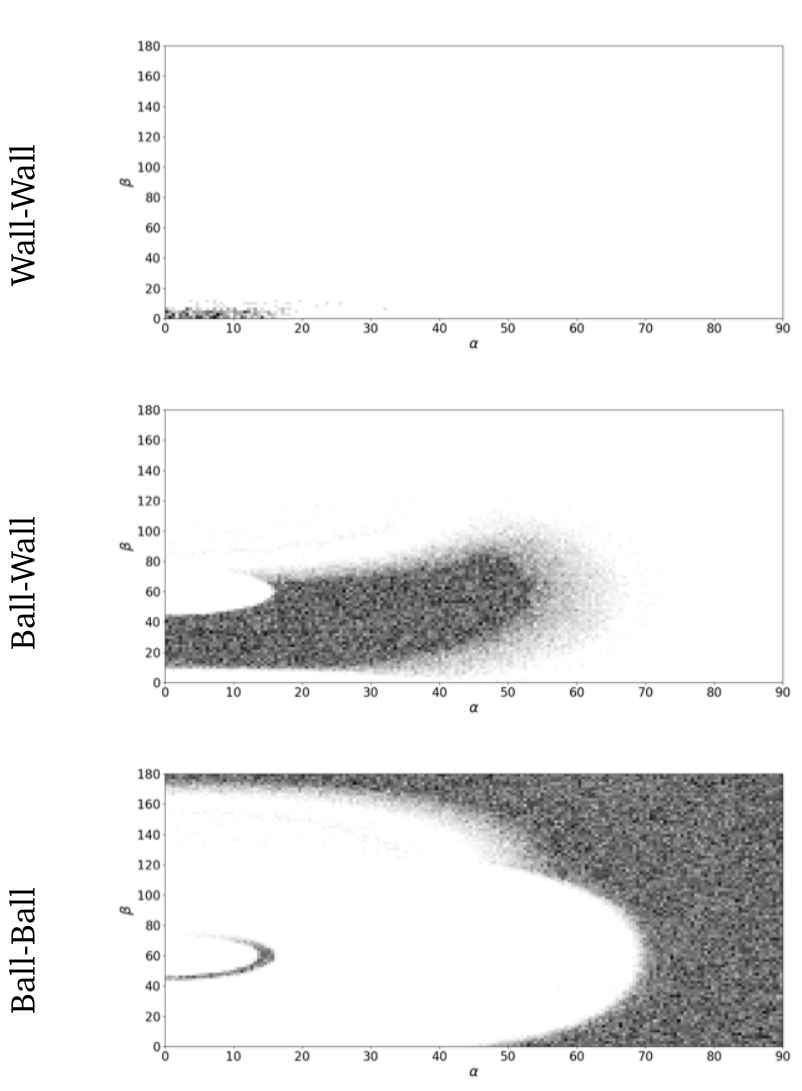
Figure 3: Simulated acceptance of the BINA detector for p(160 MeV) + d → p + p + n. 3 different kinds of coincidence: Wall-Wall ( top ), Ball-Wall ( middle ), Ball-Ball ( bottom ). The axes are scaled in